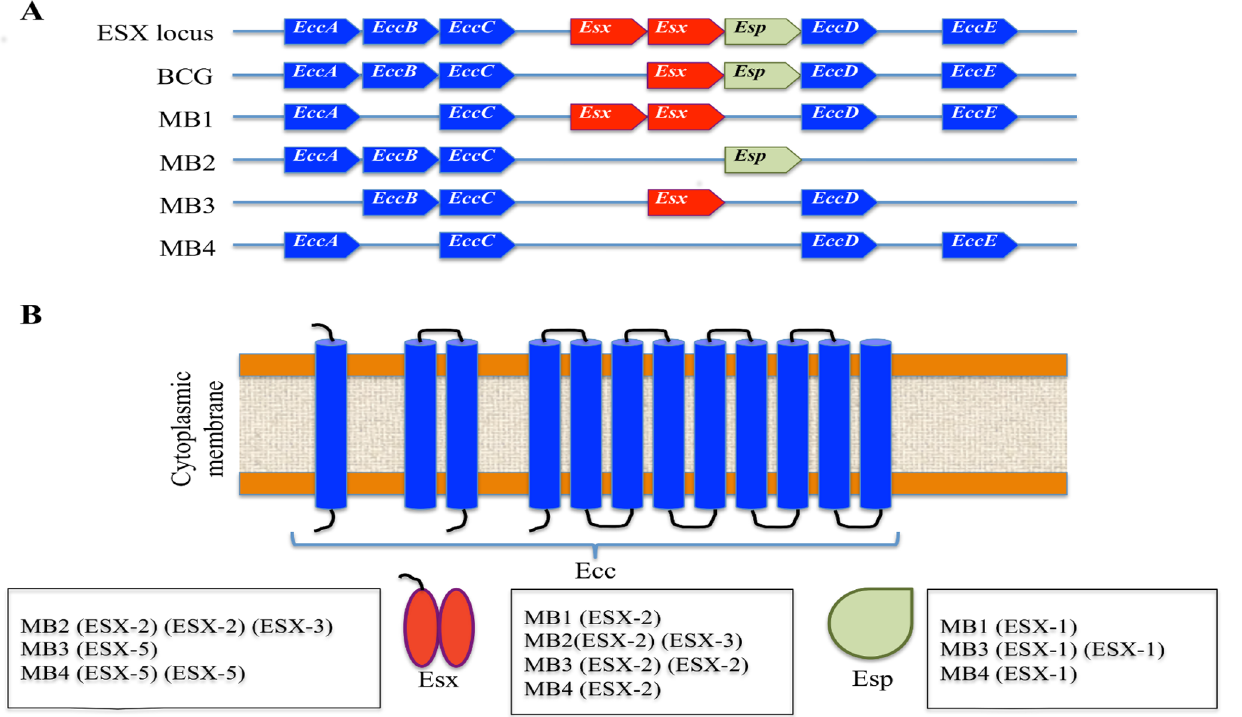
Fig 4. ESX secretion system. (A) Organization of Ecc , Esx and Esp genes in the ESX complete ESX-1 – ESX-5 loci, M . bovis BCG Pasteur 1173P2 and the genome of MB1-MB4 mycobacteria isolates. (B) Localization of Ecc, Esx and Esp proteins with reference to the ESX loci with deletions in the genome of MB1-MB4 mycobacteria isolates.